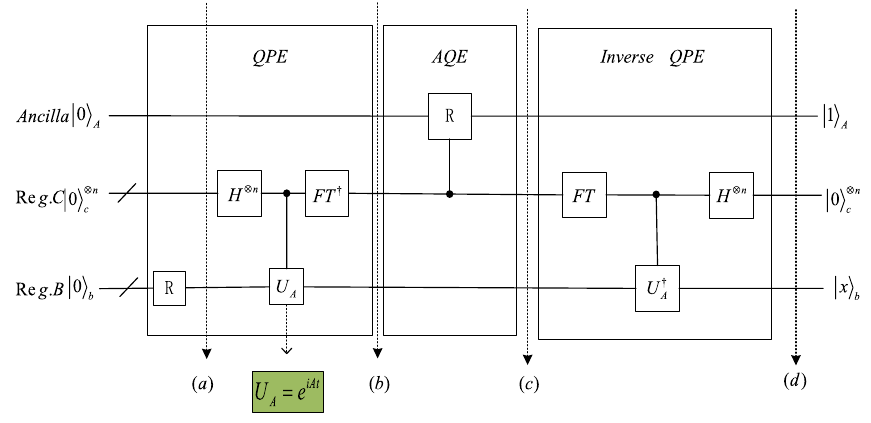
Figure 1. Circuit overview diagram of HHL